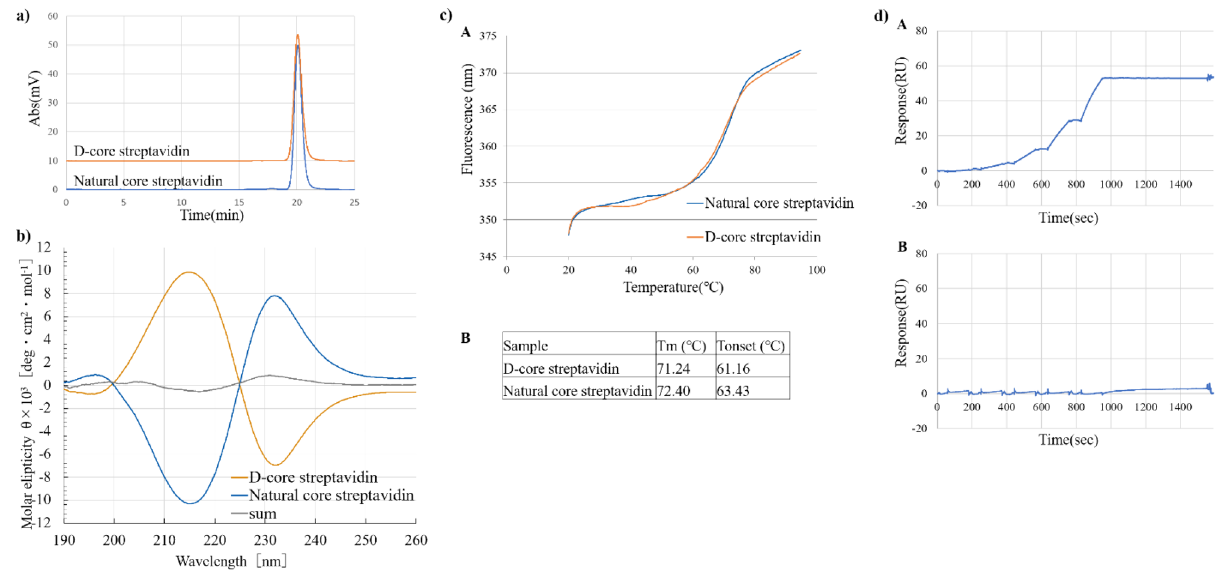
Figure 2. ( a ) SEC chart for core streptavidin. The horizontal axis shows the retention time (min), and the vertical axis shows the signal strength representing absorption at 280 nm. ( b ) CD spectra of folded D- and natural core streptavidin molecules (190–260 nm). sum: sum of CD spectra signals of D- and natural core streptavidin. ( c ) DSF curves of folded core streptavidin molecules A: DSF curves of folded D-core and natural core streptavidin molecules at concentrations of 0.5 mg/ml, B: Melting temperature (T m ) and onset temperature (T onset ) of folded natural core/D-core streptavidin. The concentrations of D-core streptavidin samples as analytes were 0.05, 0.15, 0.45, 1.35, 4.05 nM. ( d ) Biacore sensorgram for D-core streptavidin A: ligand, L-biotin; B: ligand,